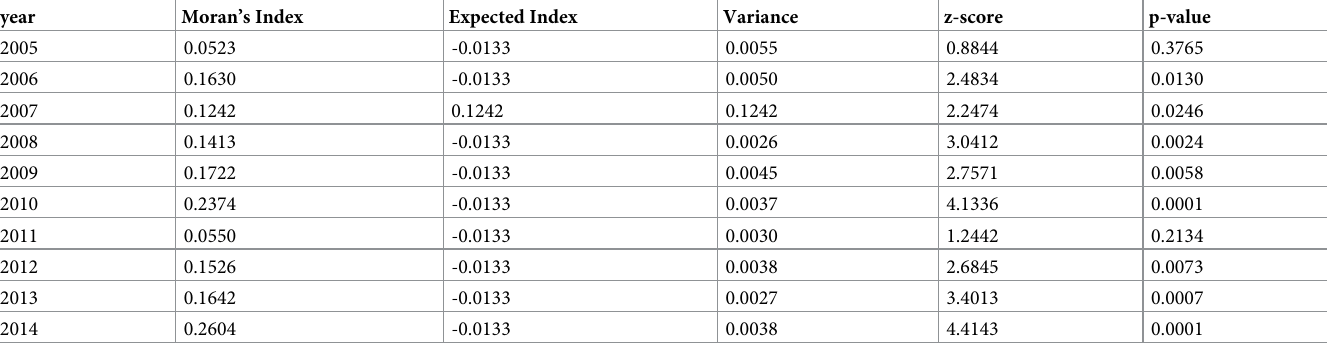
Table 1. Spatial autocorrelation results for the HFRS average annual incidence rate for each year in Hubei